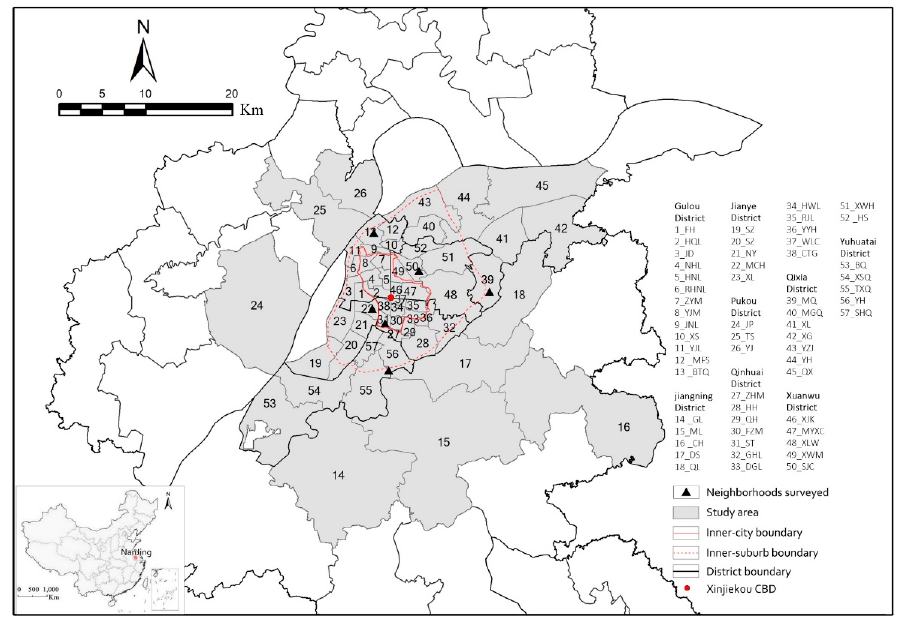
Figure 1. The geographic location of the study area and surveyed neighborhoods in Nanjing,